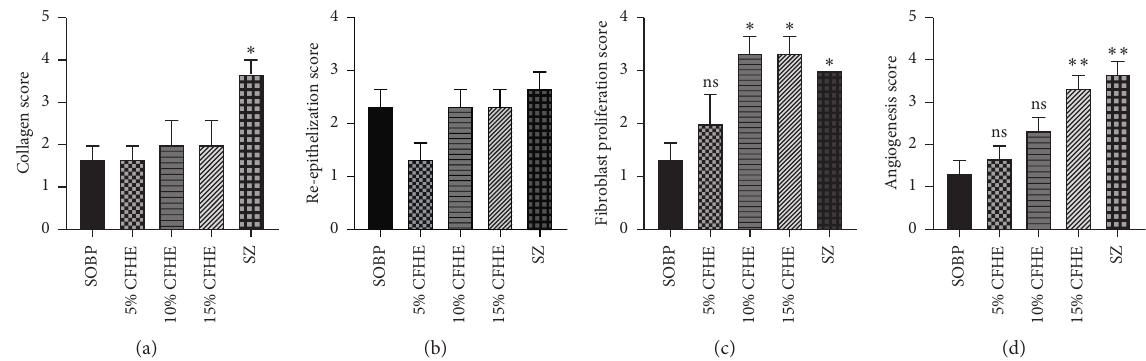
Figure 4: Effects CFHE ointment treatment on: (a) collagen deposits, (b) reepithelization, (c) fibroblast proliferation, and (d) angiogenesis in the wound-healing process in Albino rats. Values plotted are Mean ± SEM, ( n � 5). ∗∗ p ≤ 0 . 01; p ≤ 0 . 05 treatments compared to control group (one-way ANOVA followed by Dunnett’s multiple comparisons